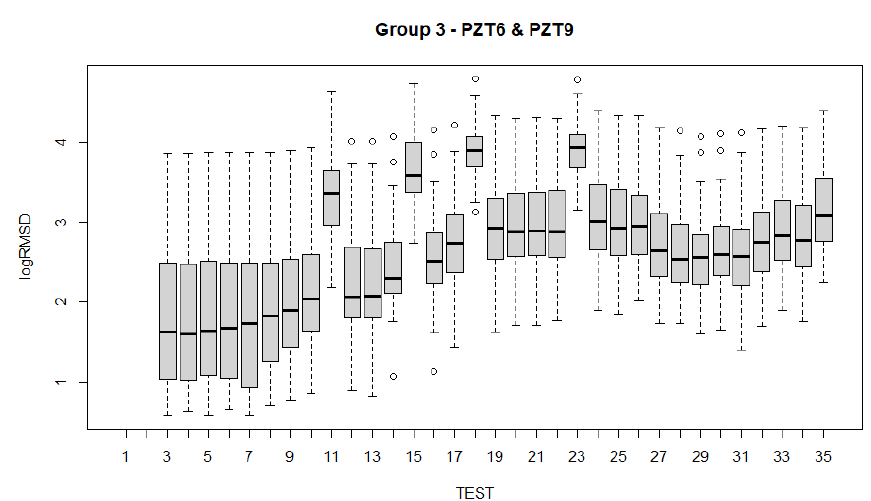
Figure 20. Boxplot for sensors of group 3.